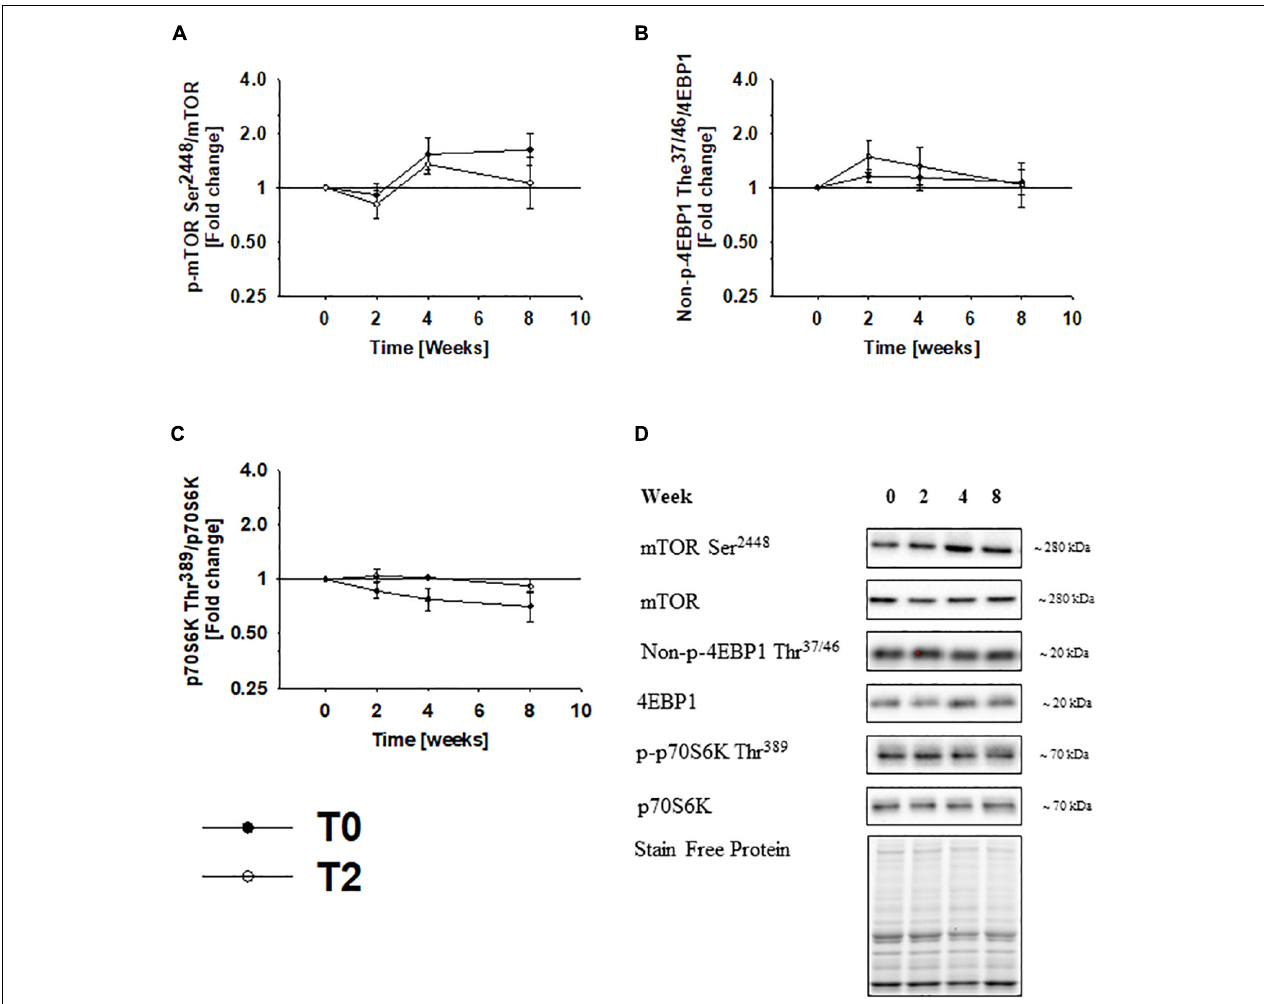
FIGURE 2 | 4EBP1 phosphorylation decreases during immobilization. mTOR phosphorylation at Ser 2448 did not change during immobilization or rehabilitation (A) . In accordance, the mTORC1 substrates 4EBP1 phosphorylation Thr 37 / 46 and p70S6K Thr 389 remained unchanged during rehabilitation and rehabilitation (B,C) . Values are geometric means ± back transformed SE. Representative western blots (D) . Based on the applied molecular standards, approximated molecular weights are indicated on the right. Filled symbols represent subjects from T0 and open symbols represent subjects from